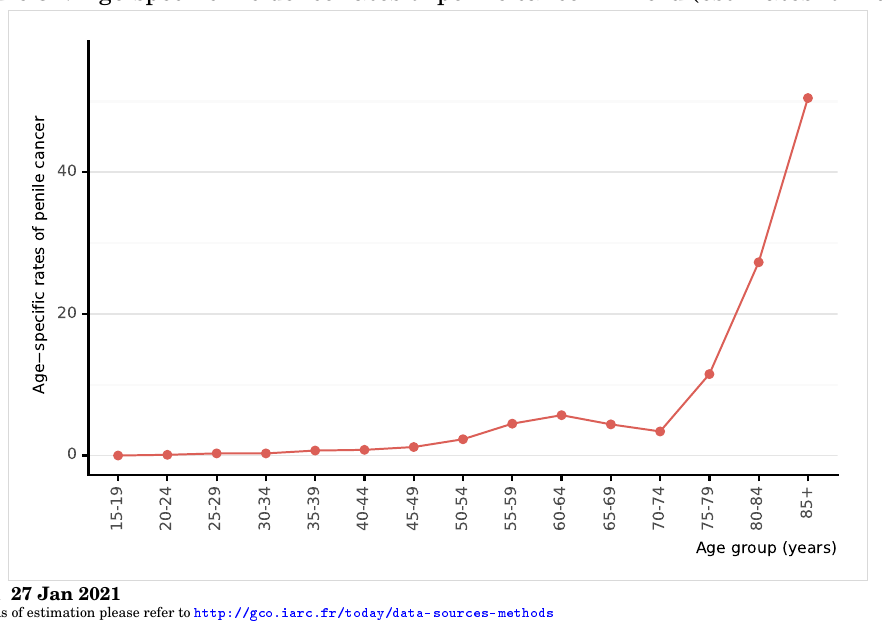
Figure 31: Age-specific incidence rates of penile cancer in Peru (estimates for 2020)